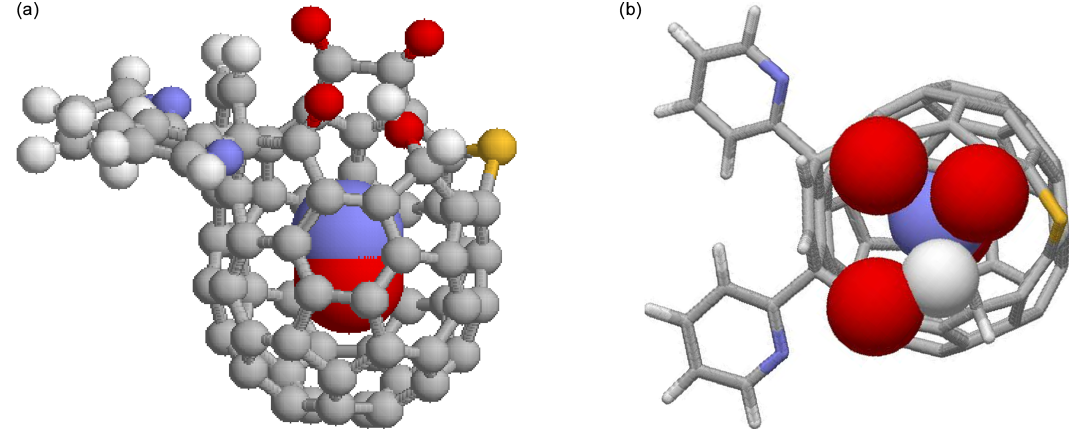
Figure 1. DFT-optimized structure of NO@C60-OH1 with N “up”. (a) Ball-and-stick representation of the modified C 60 cage and van der Waals spheres of the caged NO with carbon (grey), hydrogen (white), nitrogen (blue), oxygen (red), and sulfur (yellow). (b) Top view on the orifice with stick representation of the cage except van der Waals spheres for the oxygen and hydrogen atoms of the orifice and the caged NO.